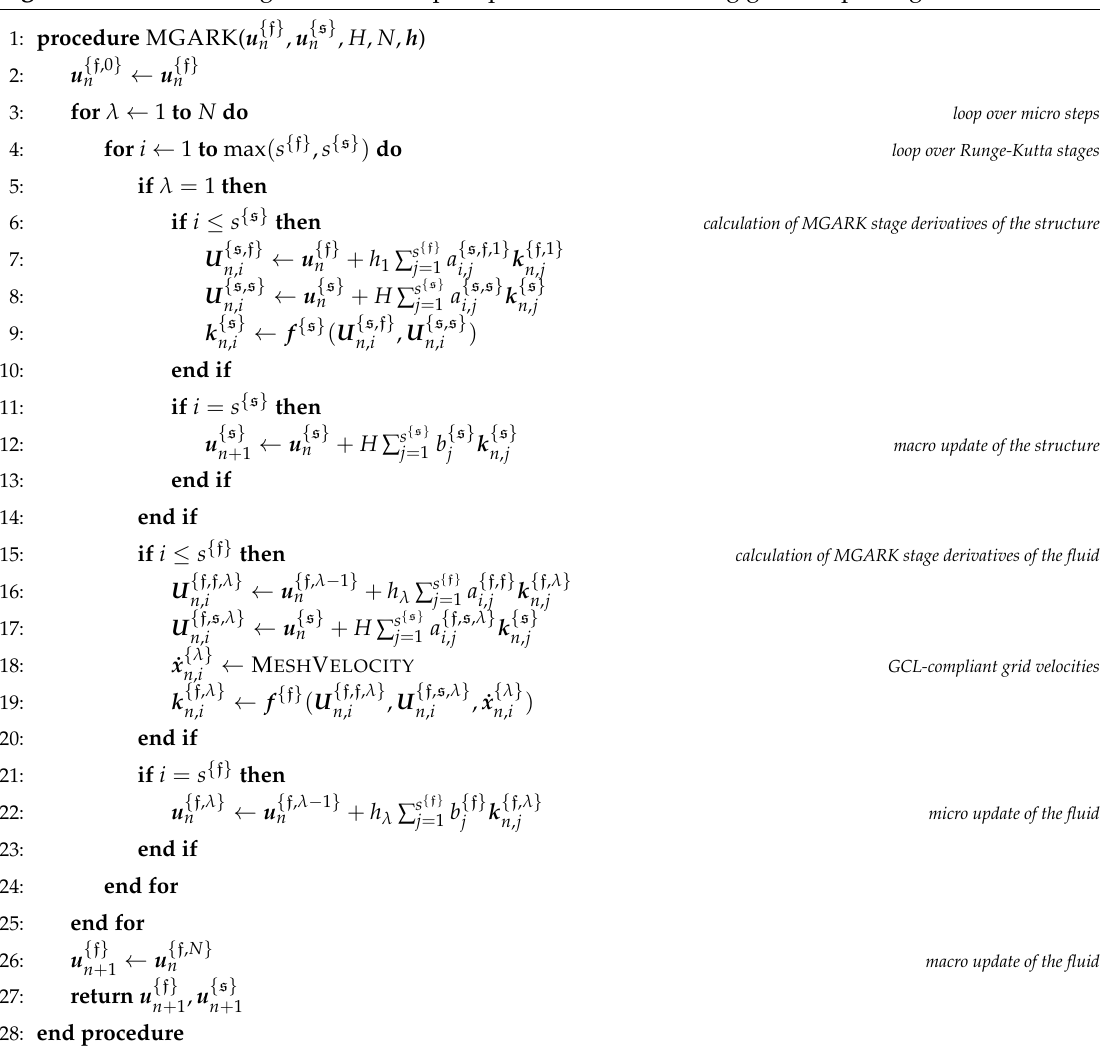
Algorithm 1 MGARK algorithm for coupled problems with moving grids respecting the